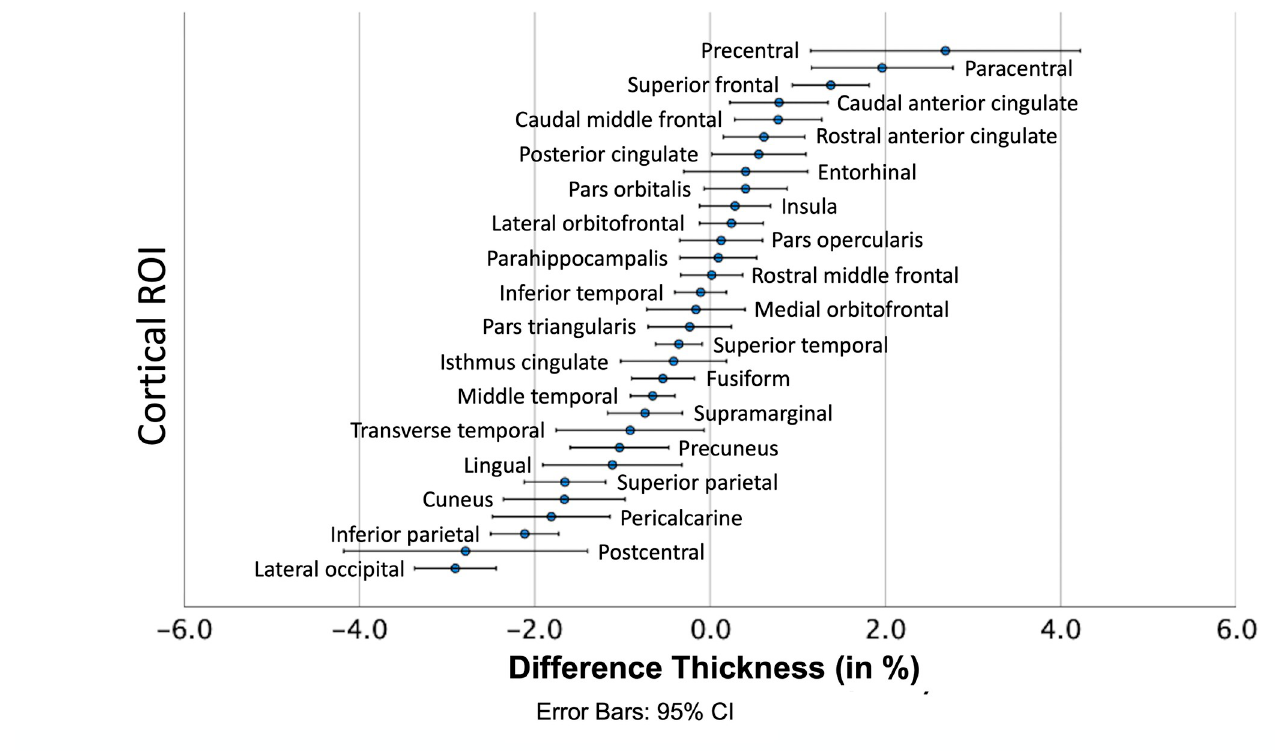
Fig 3. Mean differences of thickness for each ROI between nDC and DC data. The ROIs (y axis) are sorted by their mean percentage differences. The dot indicates the mean, and the error bars indicate the 95% confidence interval.